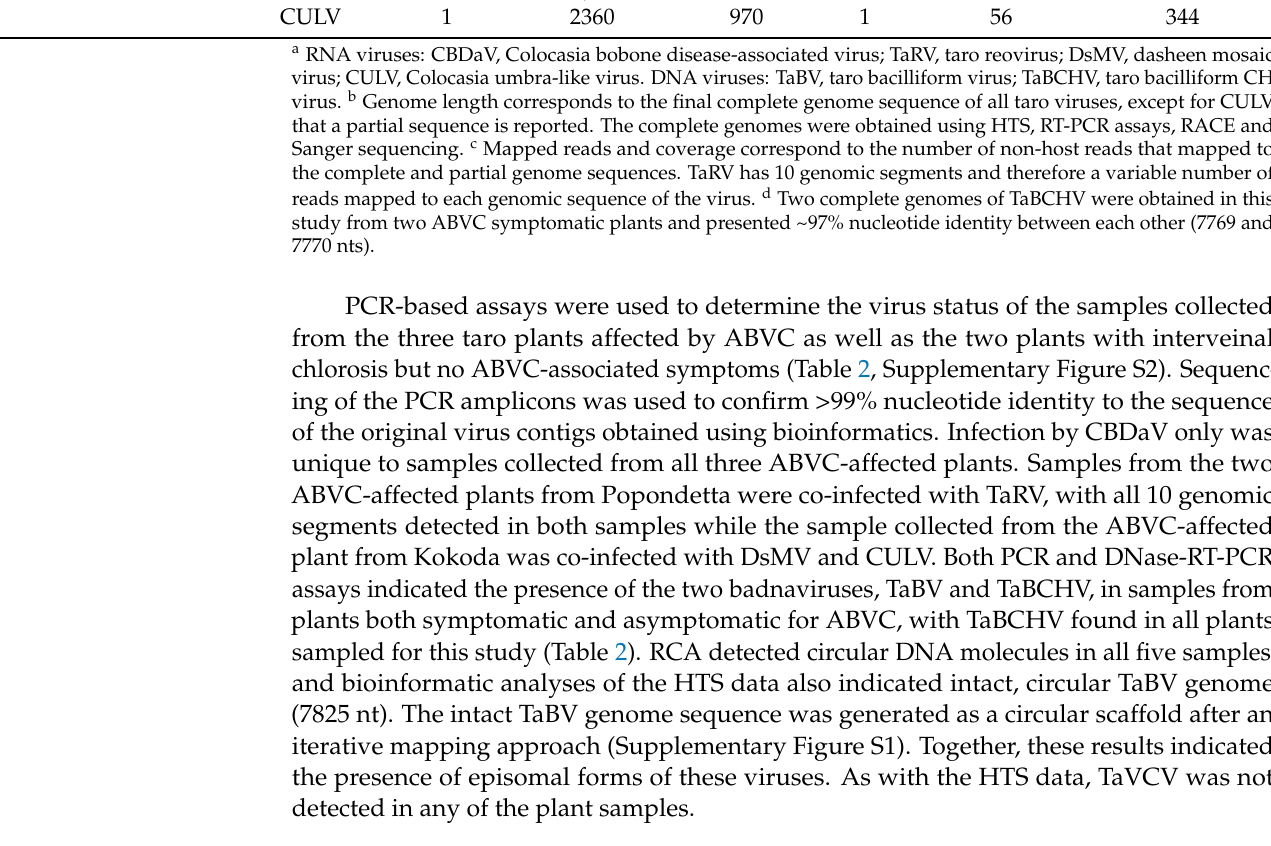
Table 2. Virus indexing in taro plants with and without symptoms of ABVC collected from three locations, Popondetta, Kokoda, and Girua, in Papua New Guinea using RT-PCR assays and primer sets detailed in Supplementary Table S1. Full virus names are found in the main